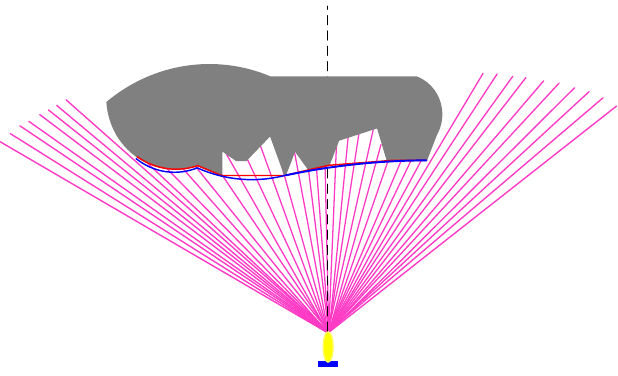
Figure 6. Obstacle surface effect after using the convex algorithm and Bessel interpolation.